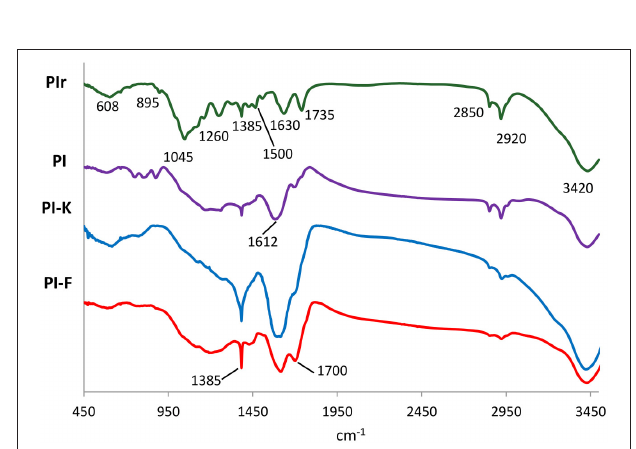
FIGURE 3 | FTIR spectra of raw pistachio shells (PIr) and biochars PI, PI-K, and PI-F.